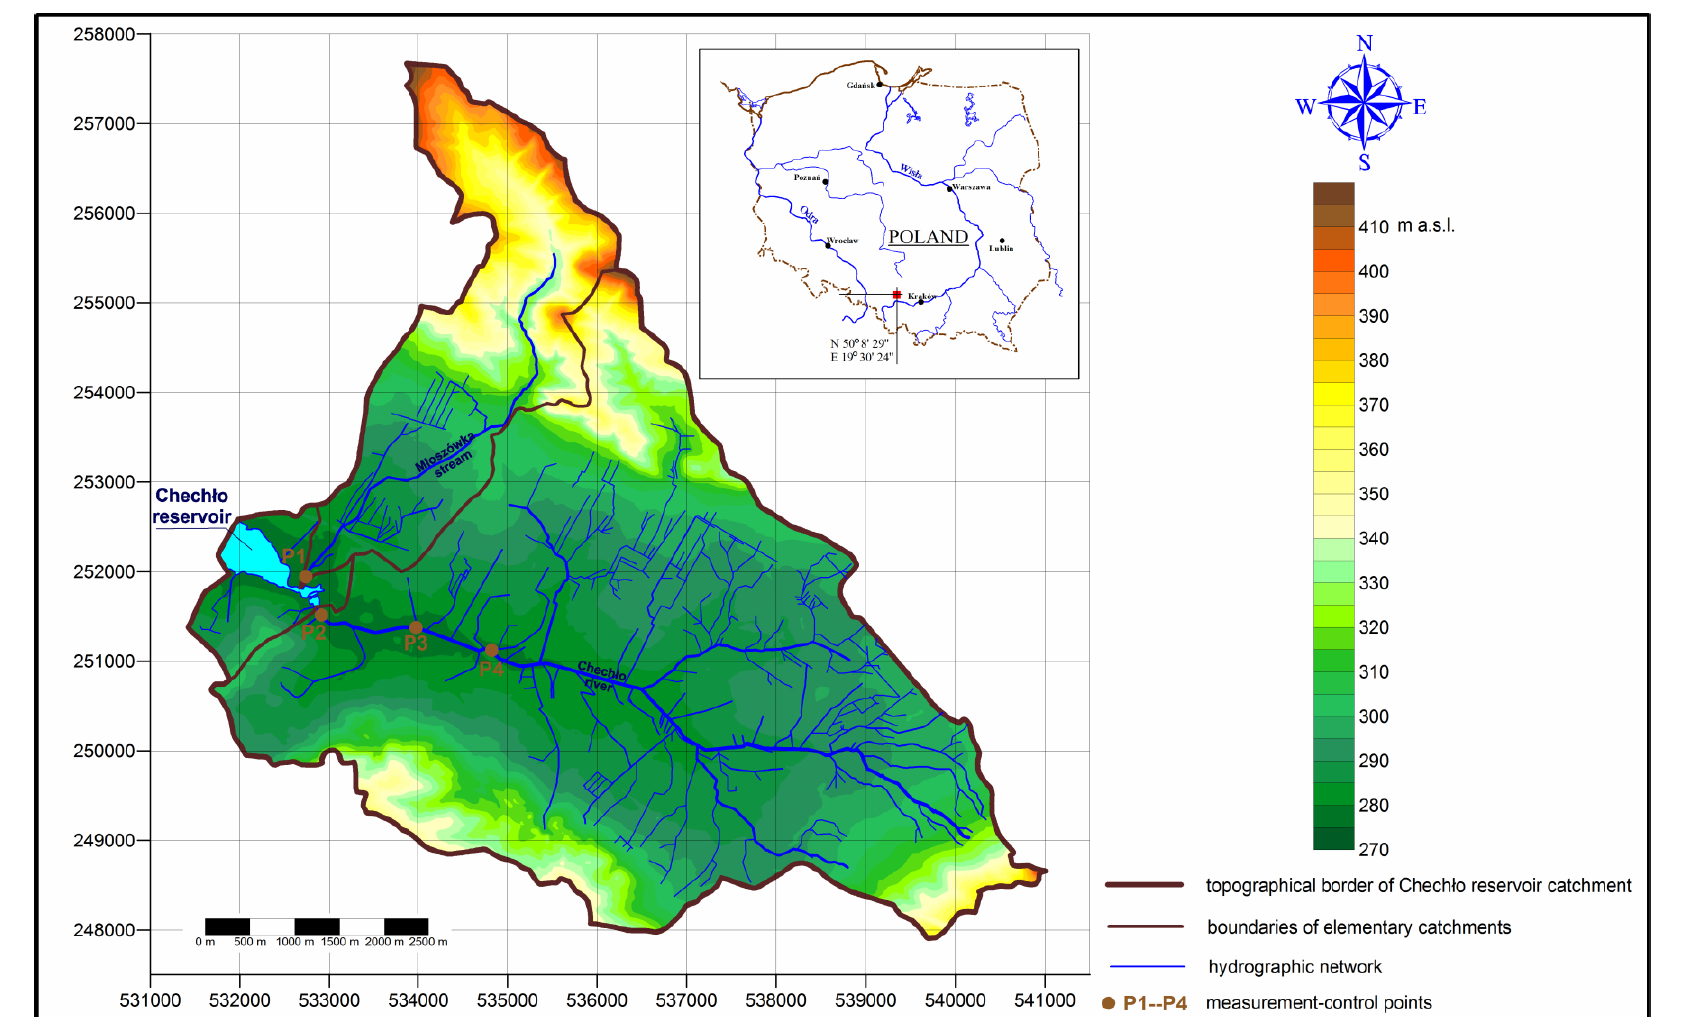
Figure 1. Hydrographic map of research catchments.